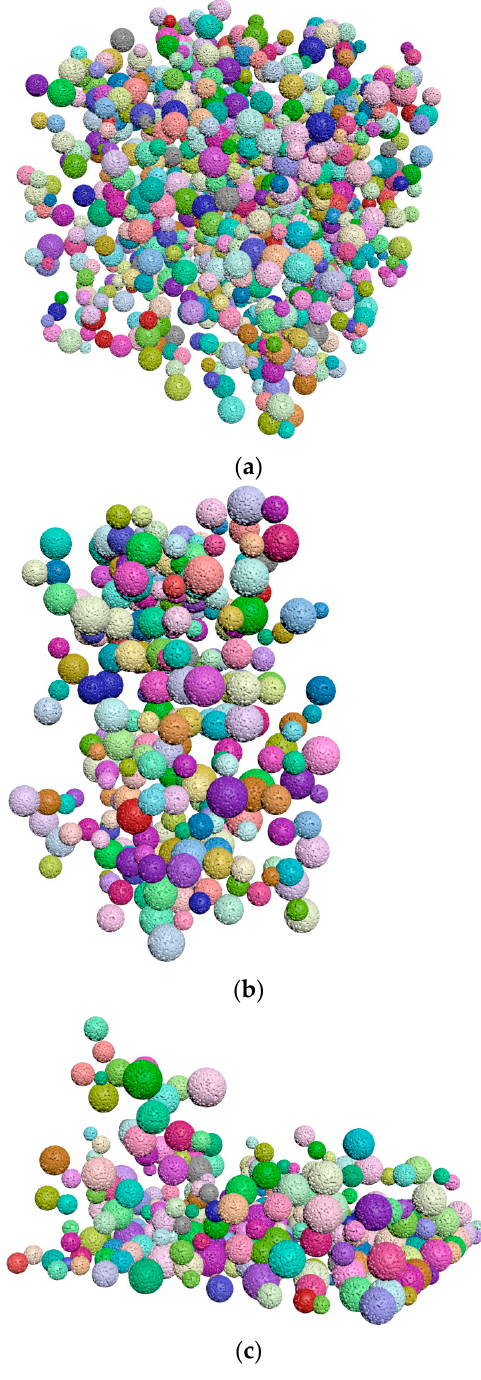
Figure 4. The result of the filtering algorithm execution. ( a ) Uniform distribution along x, y, and z, ( b ) Normal distribution along the x direction, ( c ) Exponential distribution along the z direction.